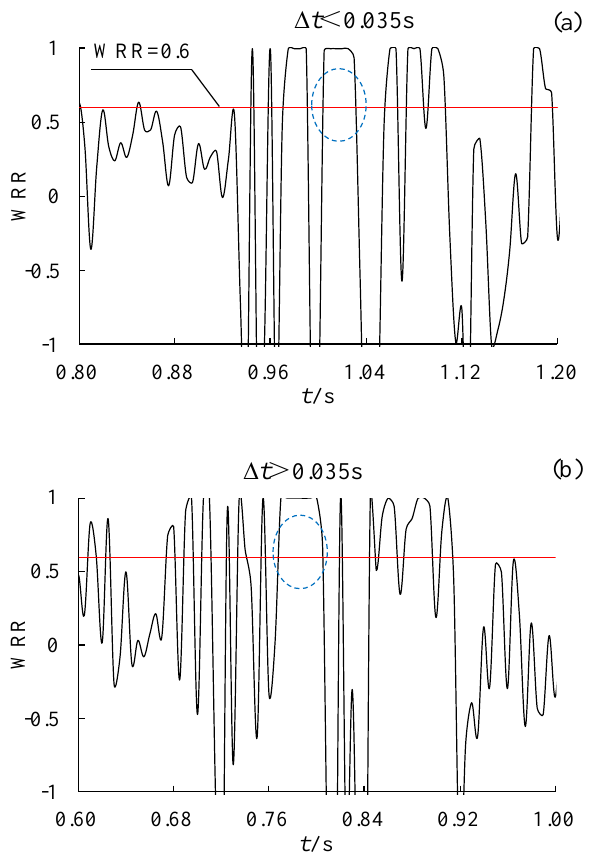
Figure 23. Partial magnification of the wheel reduction rate at the third wheel of the windward side of the head carriage: ( a ) train speed = 250 km/h and ( b ) train speed = 300 km/h.